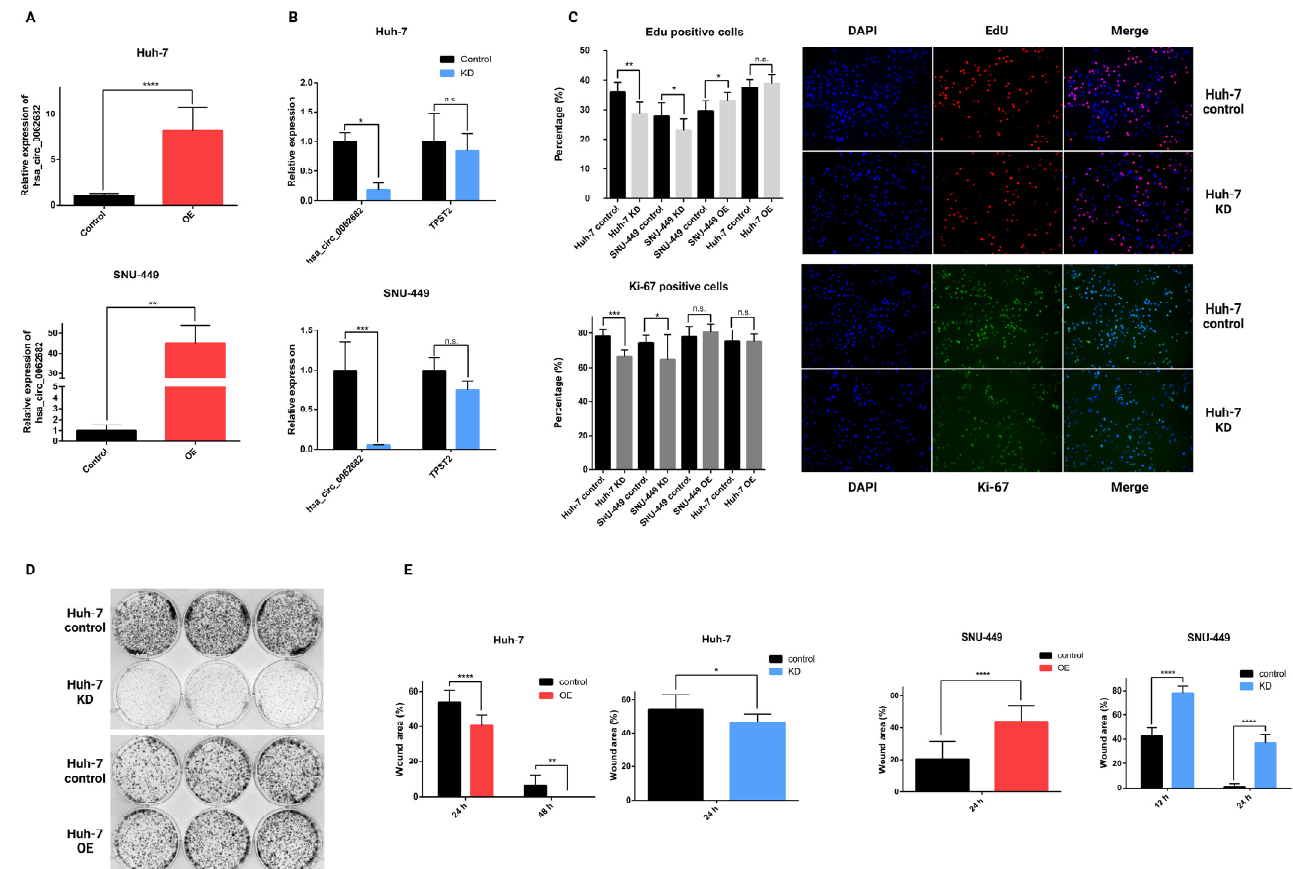
Figure 4. Stable overexpression (OE) and knockdown (KD) of hsa_circ_0062682 in HCC model cell lines. ( A ) Relative expression of hsa_circ_0062682 in overexpressing Huh-7 (n = 3) and SNU-449 (n = 3) cell lines; ( B ) relative expression of hsa_circ_0062682 and TPST2 in a knockdown of hsa_circ_0062682 in Huh-7 (n = 3) and SNU-449 (n = 3) cell lines; ( C ) EdU proliferation assay (n = 12) ( top ) and Ki-67 immunostaining (n = 12) ( bottom ) of stably transduced model cell lines Huh-7 and SNU-449; representative images of Huh-7 knockdown cell line and its representative control are shown on the right (magnification = 200 × ); ( D ) Colony forming assay in transduced Huh-7 cell lines (10,000 cells); ( E ) wound healing assay of overexpressing Huh-7 and SNU-449 (n = 11) and in a knockdown of Huh-7 and SNU-449 cell lines (n = 11); representative images can be found in Supplementary Materials (Figures S4 and S5); OE: overexpression; KD: knockdown. Results are represented as averages and error bars represent standard deviation. * p -value ≤ 0.05; ** p -value ≤ 0.01; *** p -value ≤ 0.001; **** p -value ≤ 0.0001; n.s.: not significant, Student’s t -test.